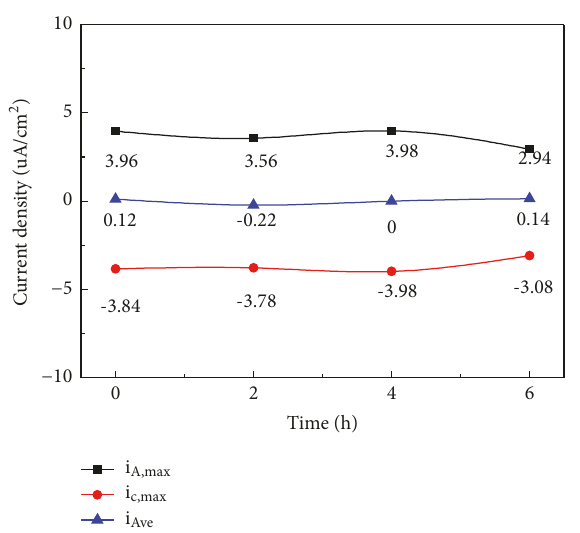
Figure 7: Integrated cathodic current (I Int ) of different microstruc-